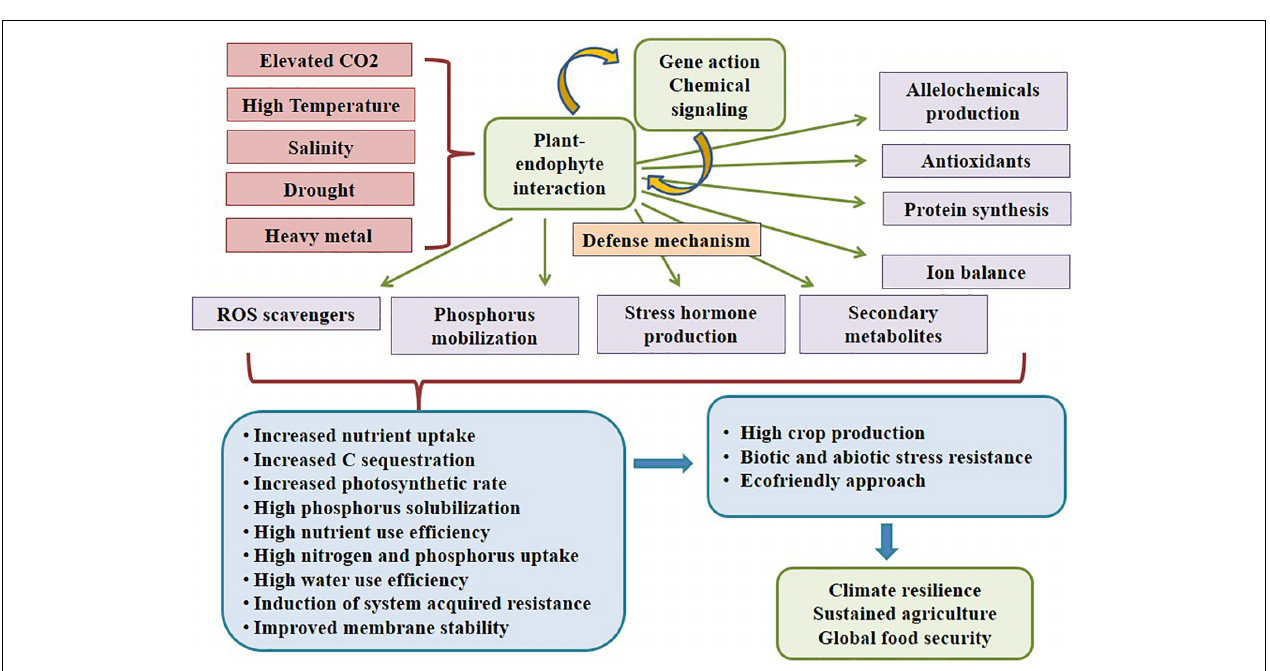
FIGURE 2 | Various components succeeding CSA-led sustainable agriculture goals.